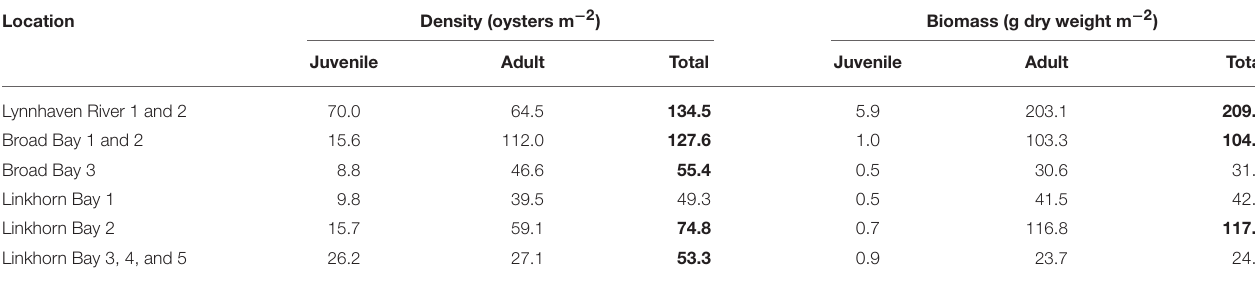
TABLE 4 | Oyster density and biomass on constructed oyster reefs in the Lynnhaven River, Broad Bay, and Linkhorn Bay. Location